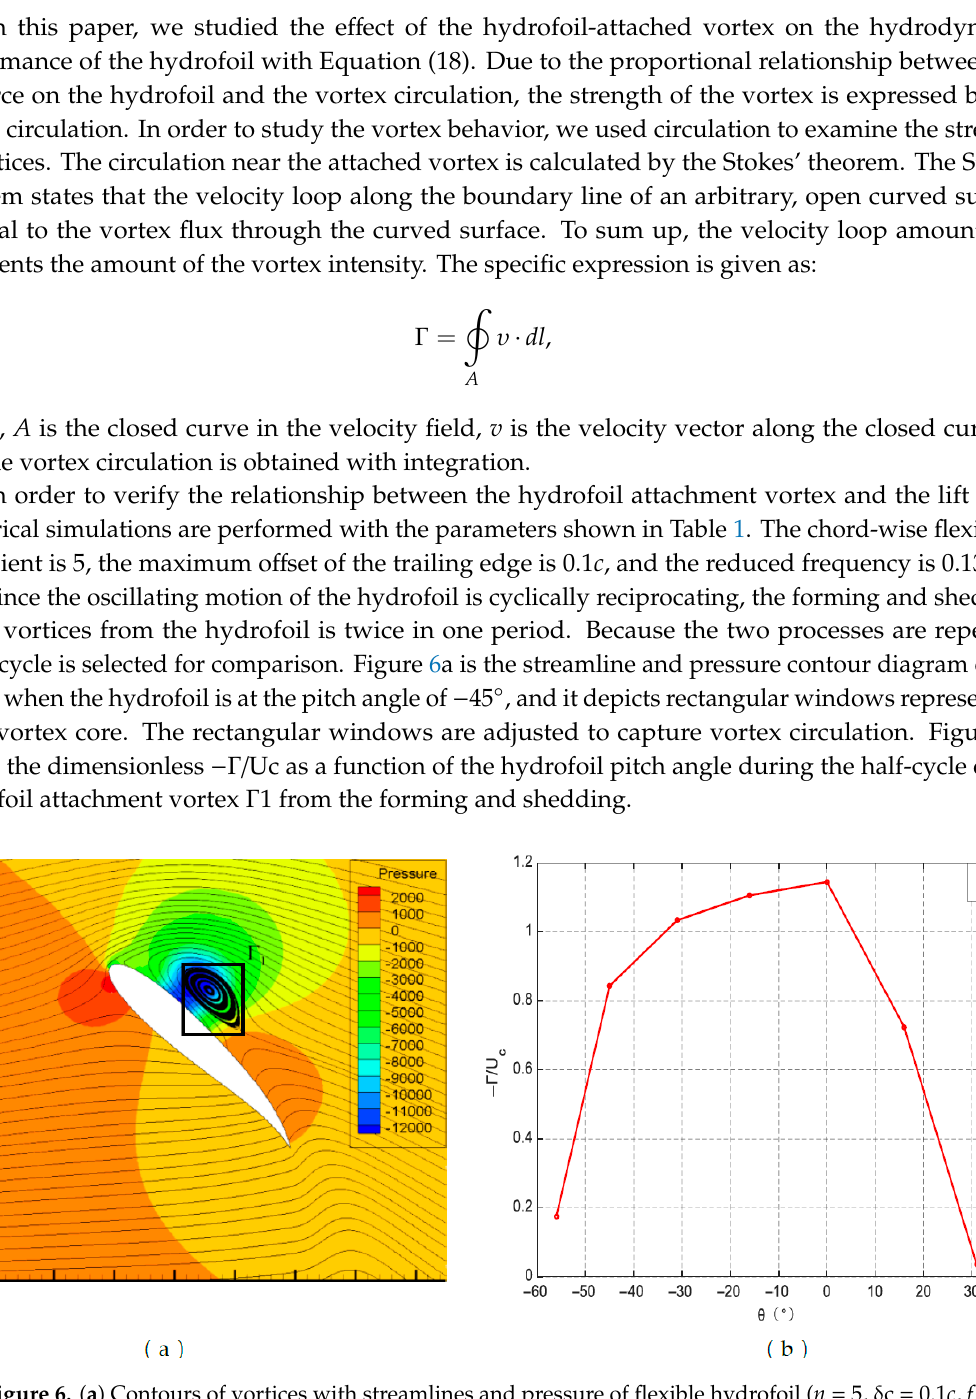
Figure 6. ( a ) Contours of vortices with streamlines and pressure of flexible hydrofoil ( n = 5, δ c = 0.1 c , f * = 0.13) with θ = 45 ◦ . ( b ) The curve diagram of − Γ / Uc change with pitch angle in the case n = 5, δ c = 0.1 c and f * =